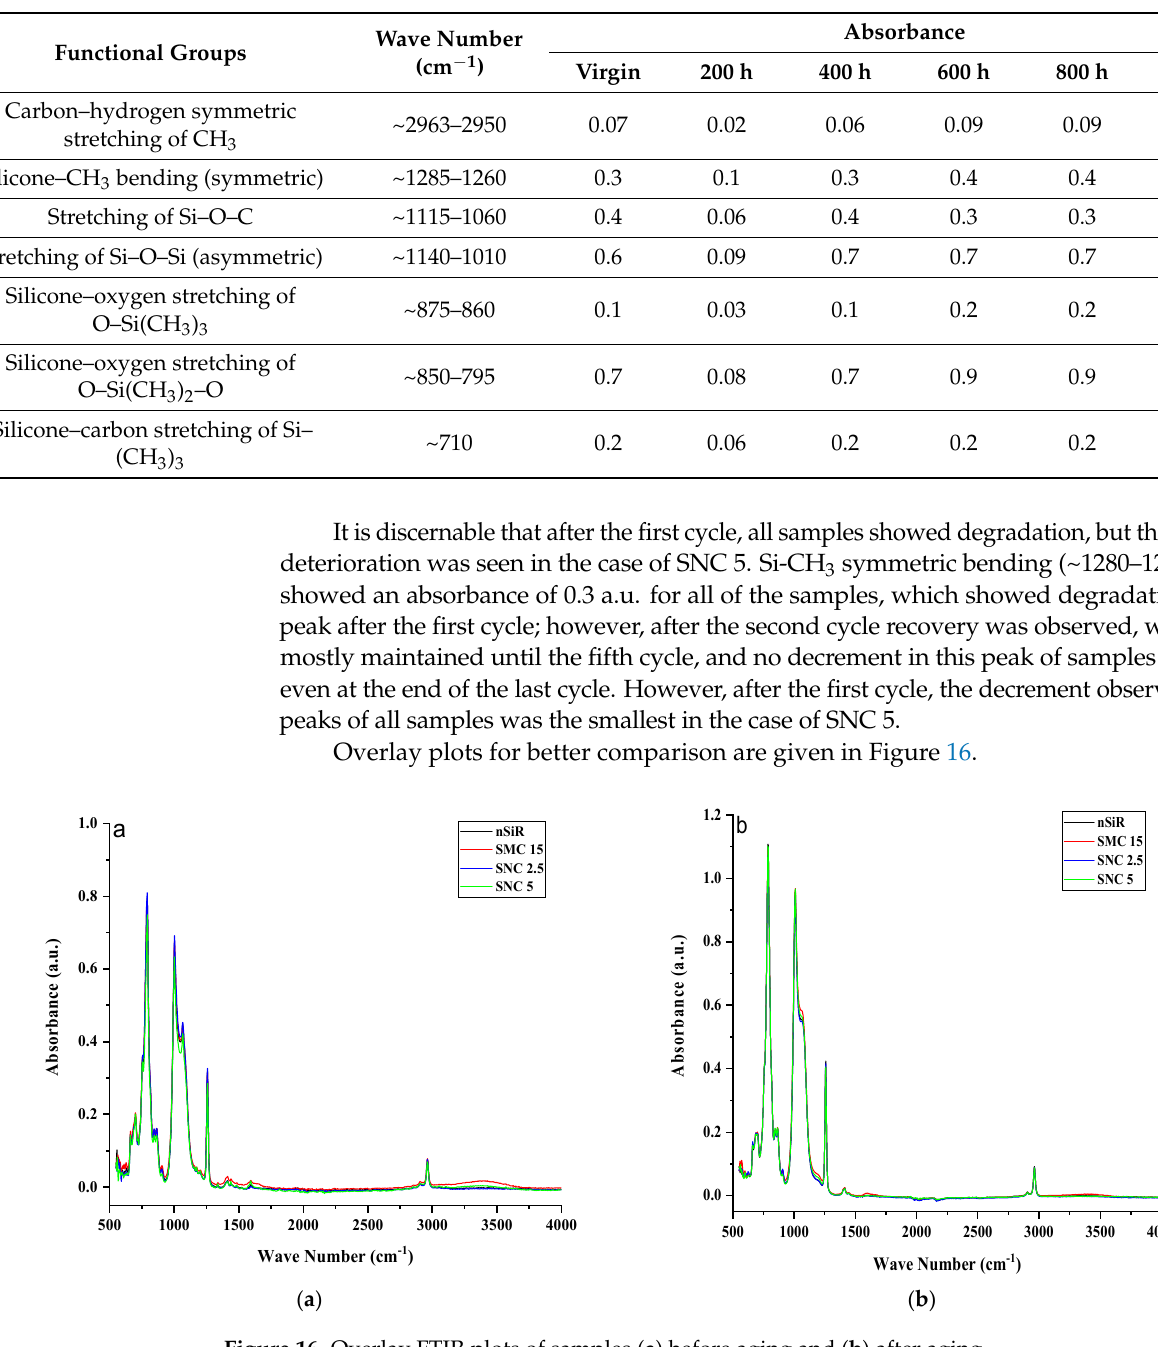
Table 6. Peak absorption of major groups in SNC 5 from virgin to 1000 h.